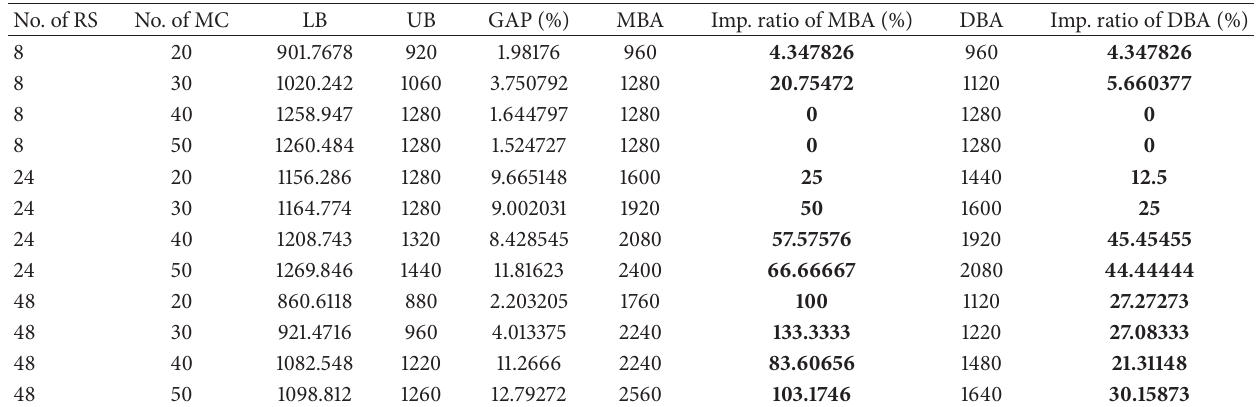
Table 6: Algorithm comparison (1BS, grid, 3.2 km).